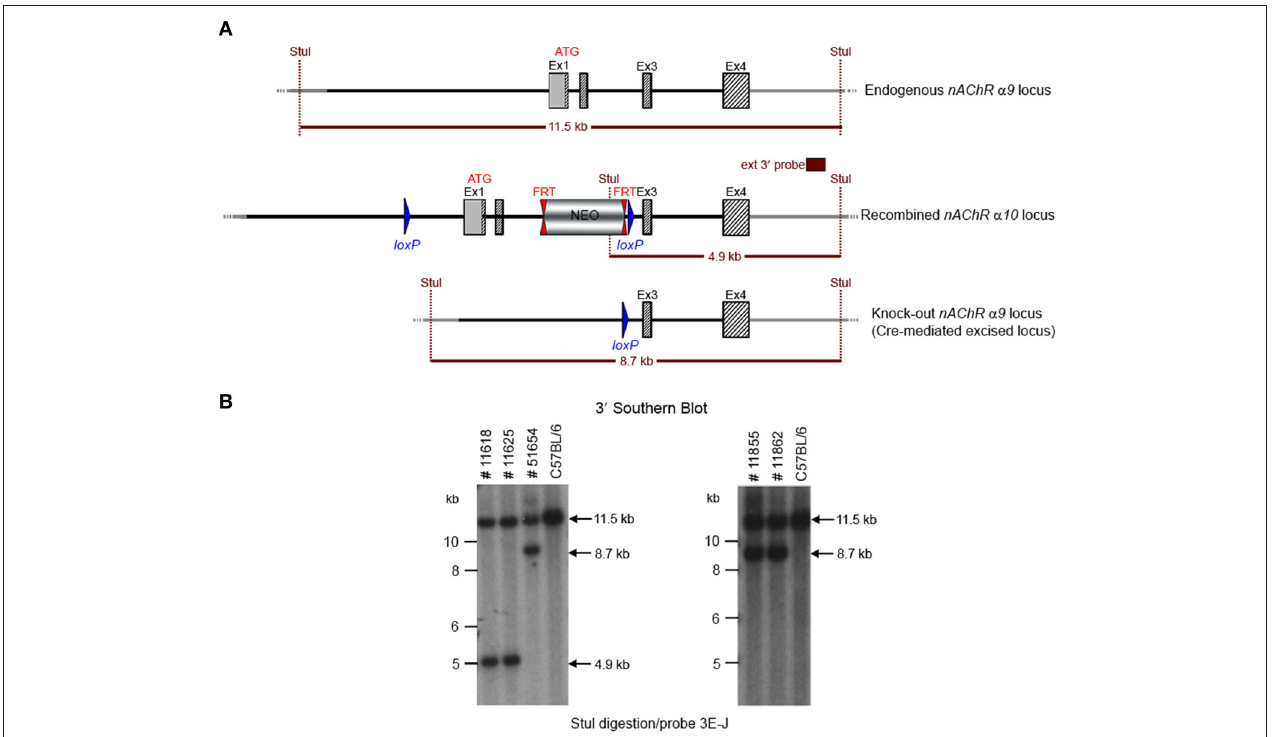
FIGURE 4 | (A) The schemata for the endogenous and recombined α 9 nAChR loci and the Cre-mediated excised locus. (B) The Southern blot analysis of the α 9 N2 generation. Genotypes of pups derived from the N2 breeding with Cre delete mice was determined by PCR as described in the Methods section. To confirm the results of the PCR, the genomic DNA of five animals (#11625, #11618, #51654, #11855, and #11862) was tested by Southern blot. StuI digested DNAs were blotted on nylon membrane and hybridized with the external 3 ′ probe (3E-J). The constitutive knockout line was established from #11862. The conditional knockout line was established from